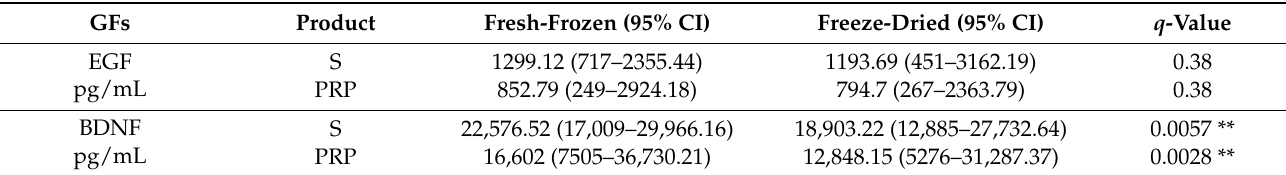
Table 2. Summary of the statistics extracted from the dataset. Each concentration was converted into a logarithmic (base 10) scale to standardize the concentration. We evaluated the geometric mean and 95% confidence intervals (mean ± std) of each concentration for each preparation in both preparation types (fresh-frozen and fresh-dried). We then compared the fresh-frozen and fresh-dried groups using a two-sided t -test to compute the associated p -value. These p -values were adjusted ( q -values) using the Benjamini–Hochberg correction for multiple tests. We used one or multiple stars (*) for the significance level of the test (0.001, 0.01, 0.05).